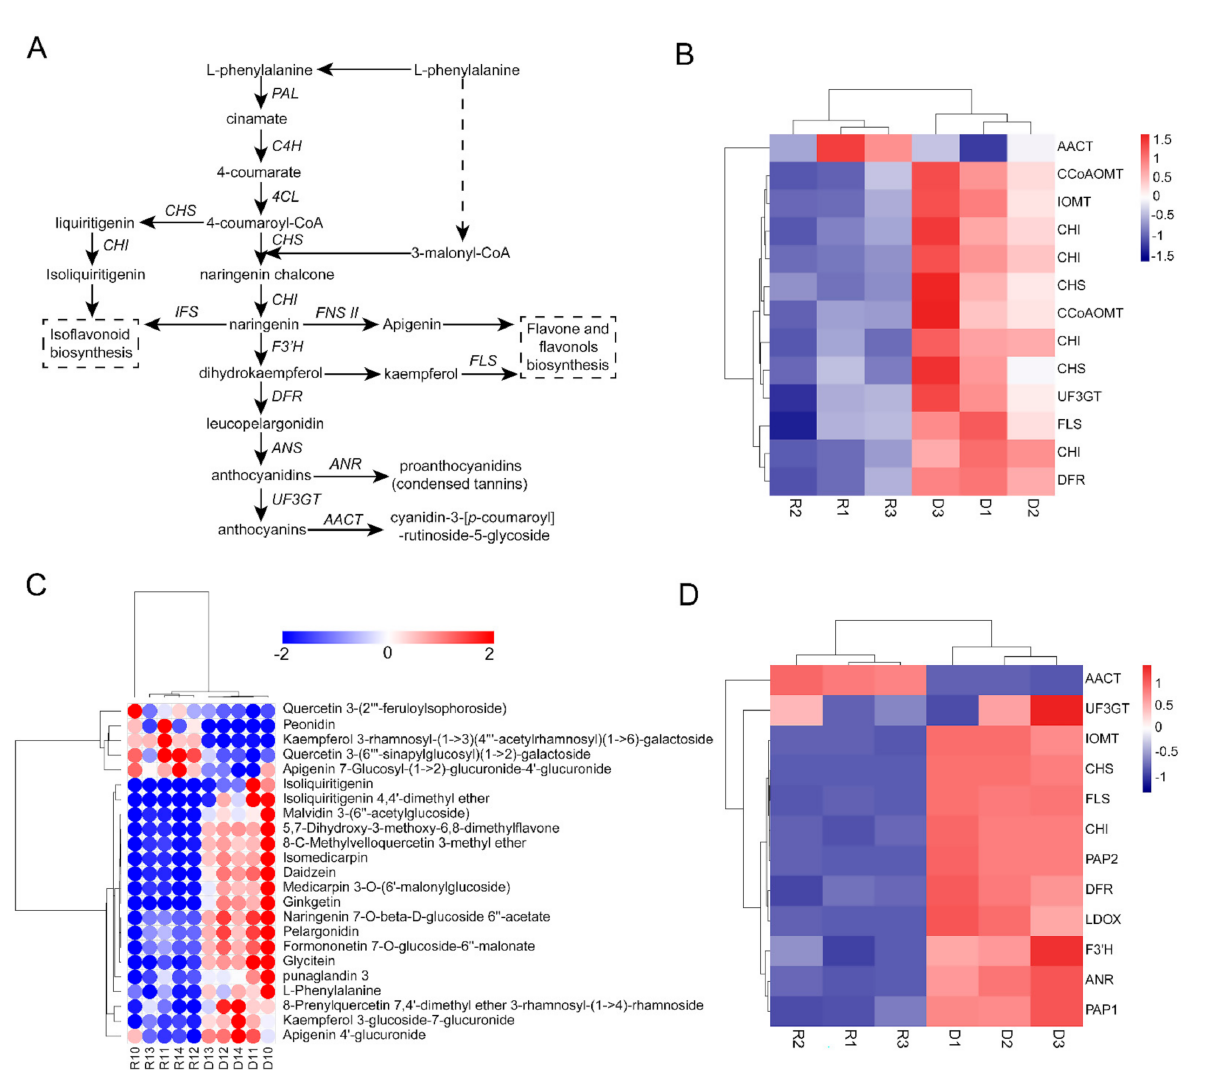
Figure 5. GAs inhibited the flavonoid and isoflavonoid biosynthetic pathways. ( A ) Anthocyanin biosynthesis pathway. ( B ) The heatmap of DEPs involved in flavonoid and isoflavonoid biosynthesis. ( C ) The heatmap of differential metabolites associated with flavonoid and isoflavonoid. ( D ) Transcription levels of flavonoid biosynthesis genes in wild-type R108 and ga3ox1 mutant. The heatmap was performed using the OmicShare tools, a free online platform for data analysis (http://www.omicshare.com/tools, 8 May 2020). According to the color scale on the right of Figure, each colorized cell represents the averaged spot quantity, and the color scale indicates the fold change in the mRNA expression